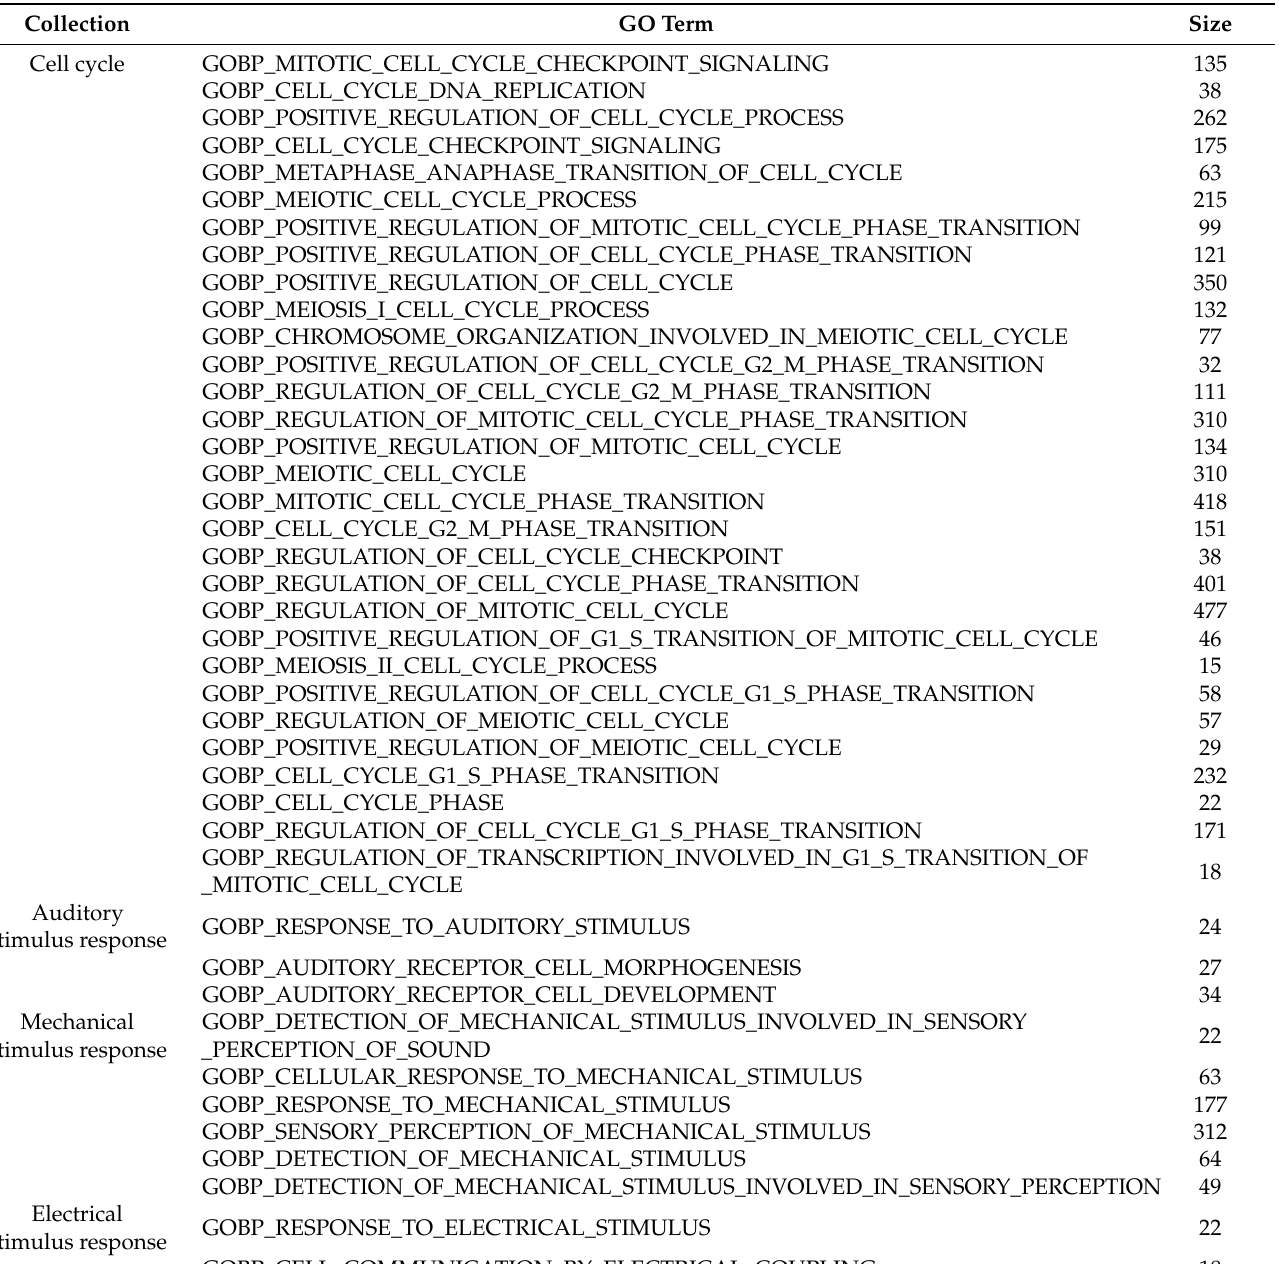
Table A1. Full list of self-defined GO term collections (M5: BP